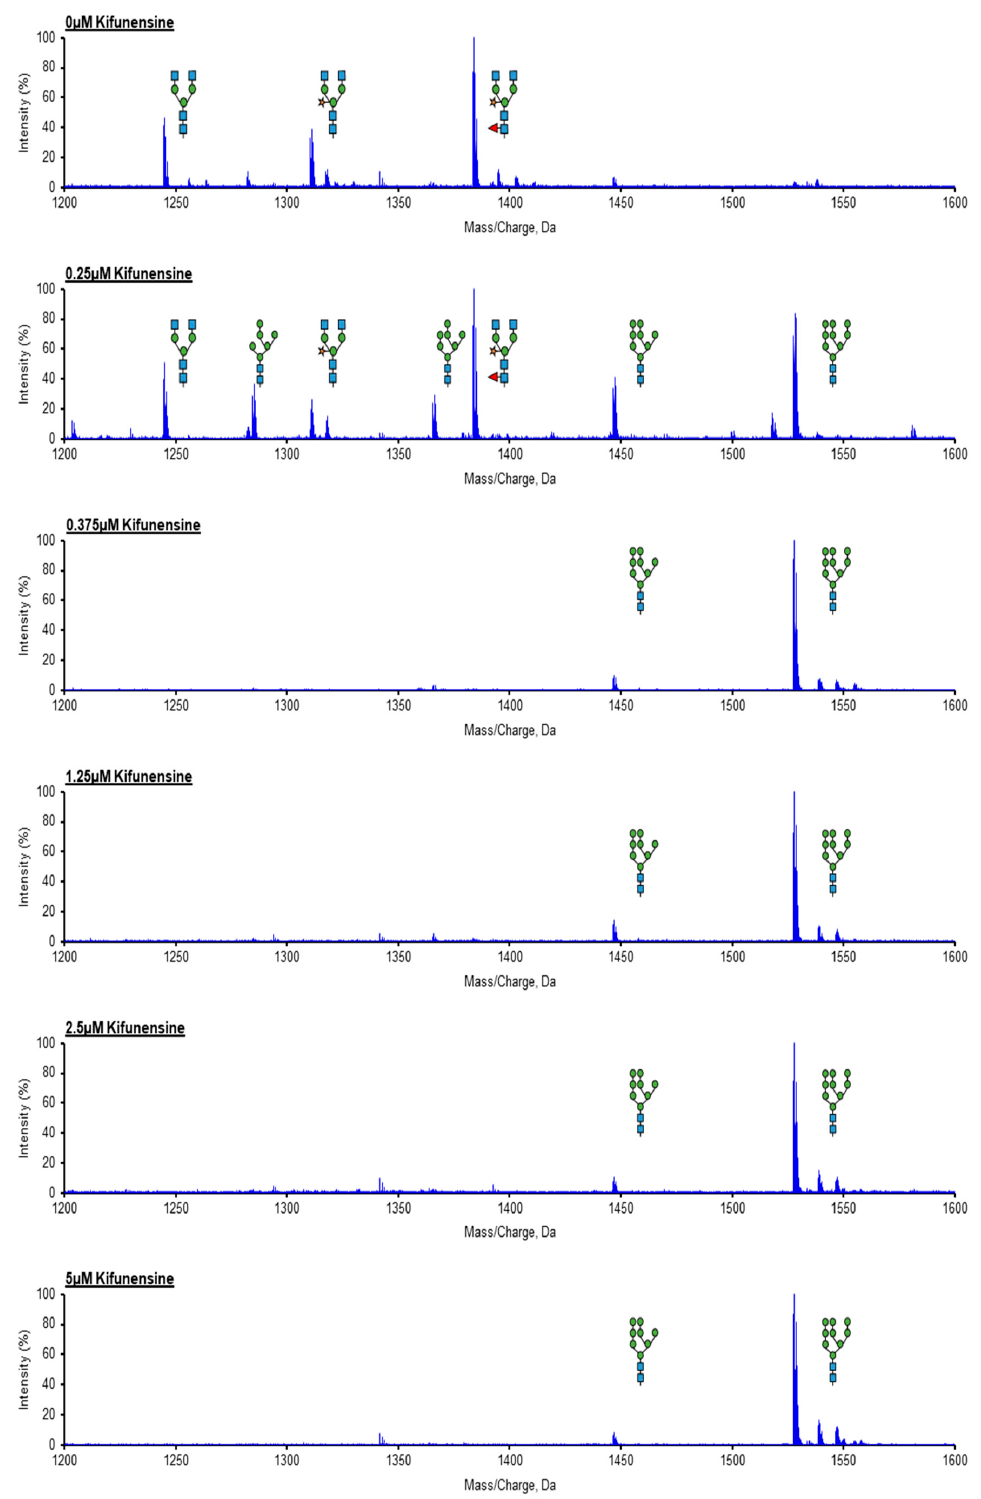
Figure 2. N-Glycan analysis of rituximab expressed in N. benthamiana plants with/without kifunensine. LC-MS (Liquid Chromatography-Mass Spectrometry) glycopeptide profiling of rituximab expressed in control and kifunensine treated plants. The distribution of glycoforms in each sample is illustrated and kifunensine concentrations are indicated on each image. Blue squares -N-acetylglucosamine; Green circles -Mannose; Orange Star- Xylose; and Red